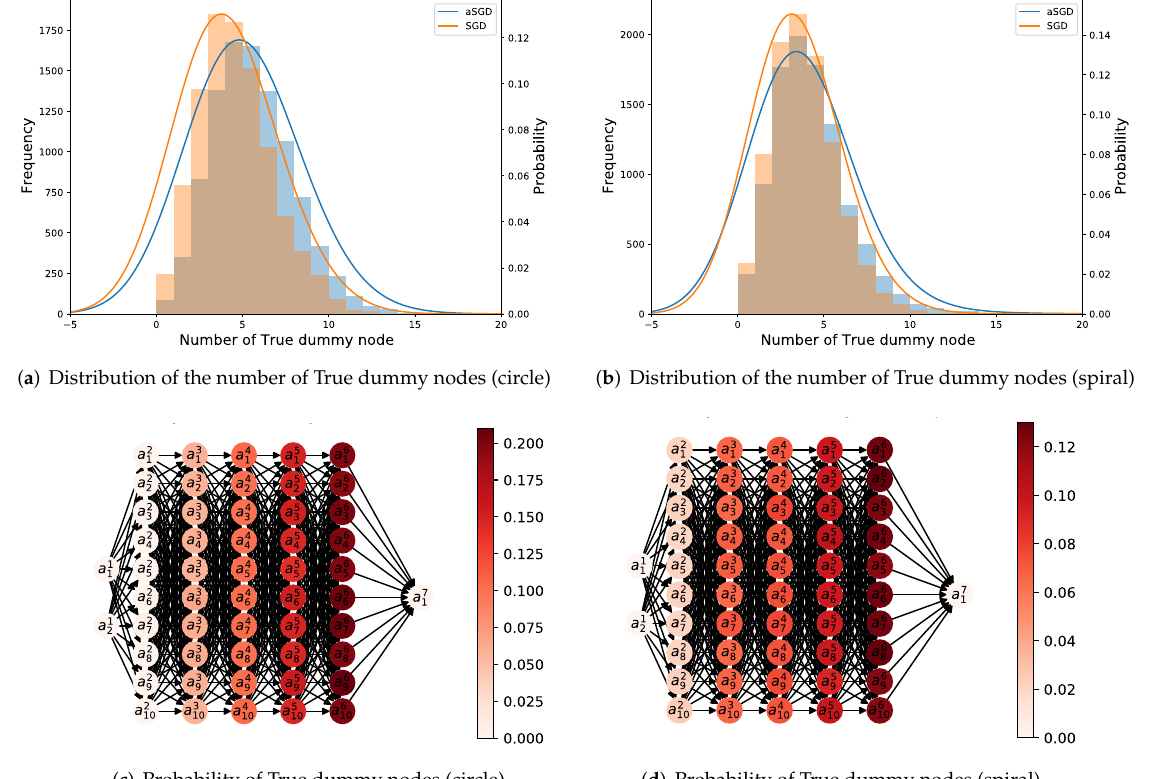
Figure 7. Histogram of true dummy nodes of ( a ) “concentric circles” and ( b ) “spiral lines”, it means the number of true dummy nodes generated by the network in one training. The probability of true dummy nodes in ( c ) “concentric circles” and ( d ) “spiral lines” at different locations of